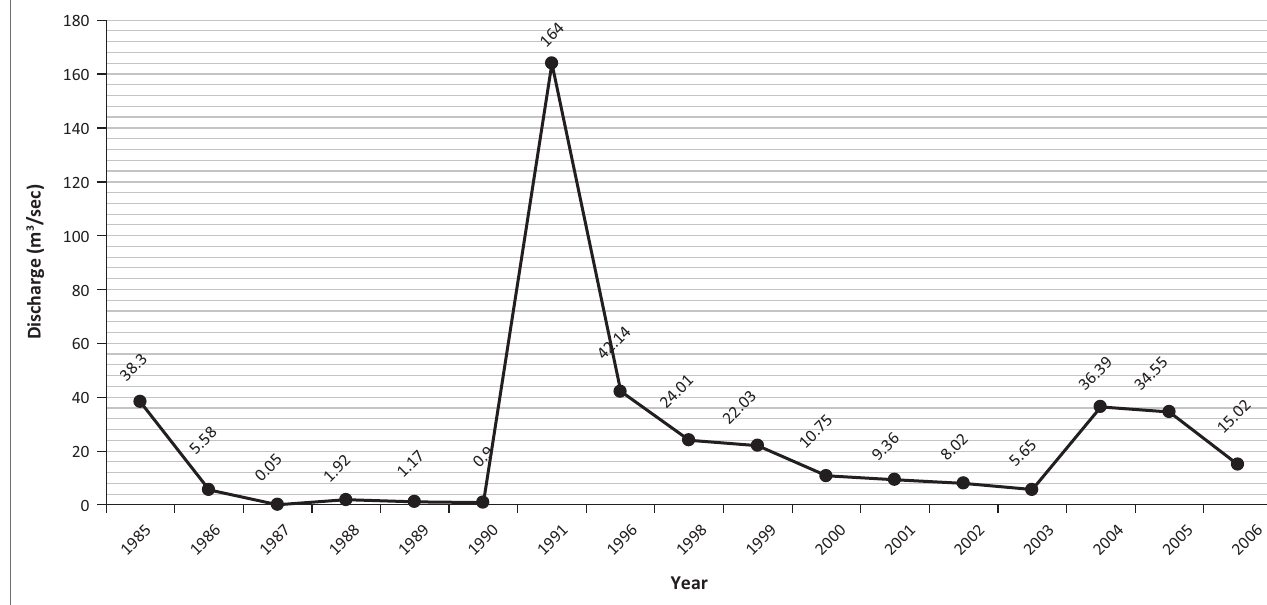
FIGURE 7: Yearly recorded minimum discharge at Dalia station from 1985 to 2006.